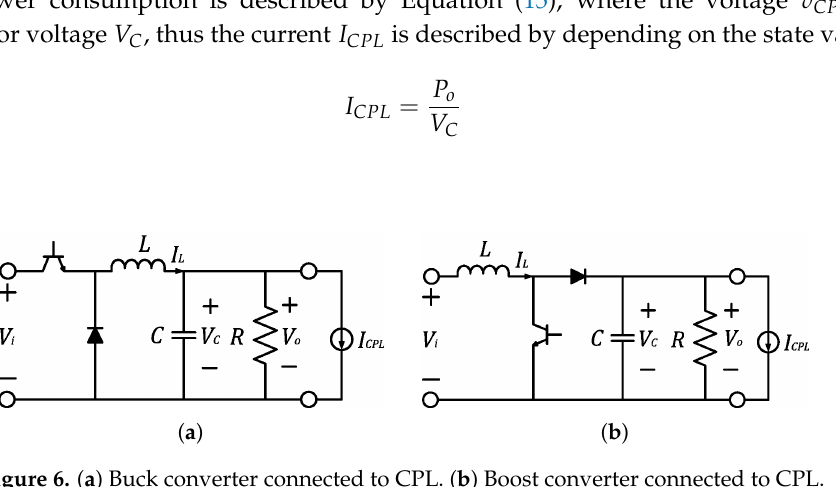
Figure 6. ( a ) Buck converter connected to CPL. ( b ) Boost converter connected to